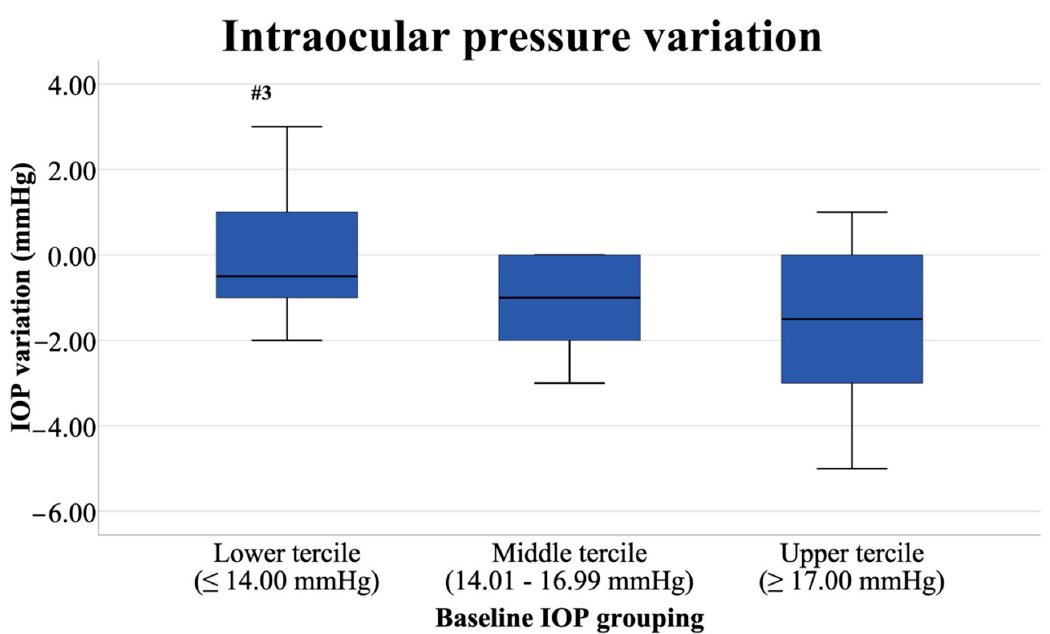
Figure 1. Intraocular pressure variation (post-exercise IOP minus pre-exercise IOP) of each of the three groups formed considering the baseline IOP levels (lower: n = 18; middle: n = 17; upper: n = 14). Values of the vertical axis (IOP variation) are presented in mmHg. The symbol “#3” highlights significant differences with the Upper-Tercile Group ( p = 0.008, d unb = 0.96).